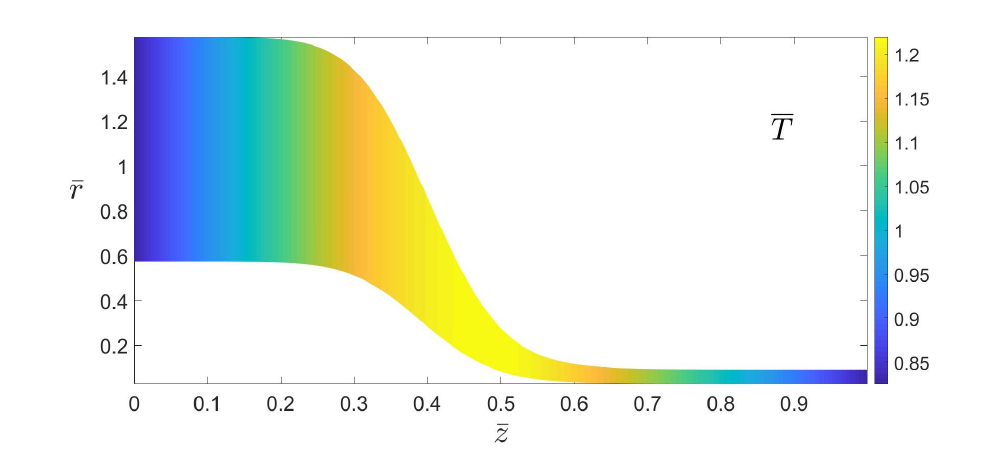
Figure 4. Fibre temperature contour in the case of DR54-15, T peak = 2050 ◦ C and no internal pressurization.